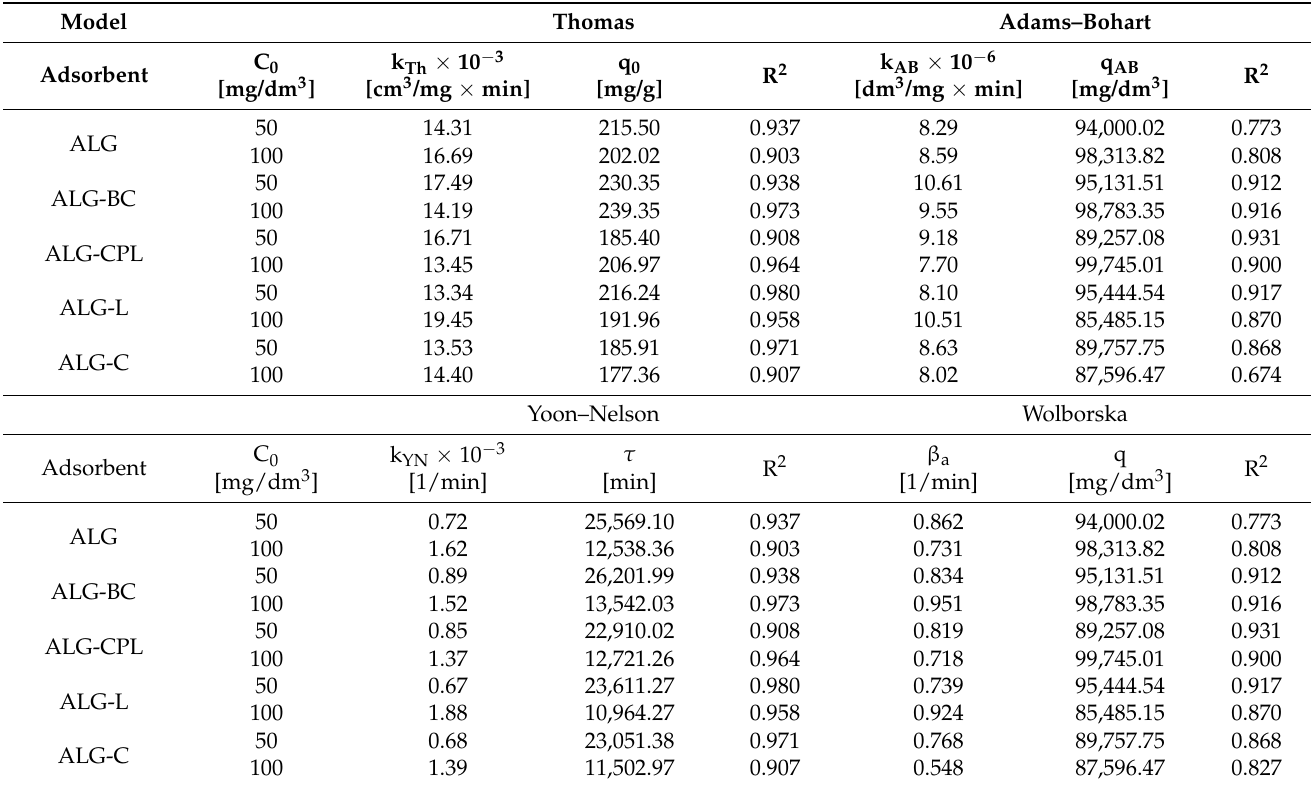
Table 3. Breakthrough fitting models results for the La(III) ions adsorption on the alginate-based